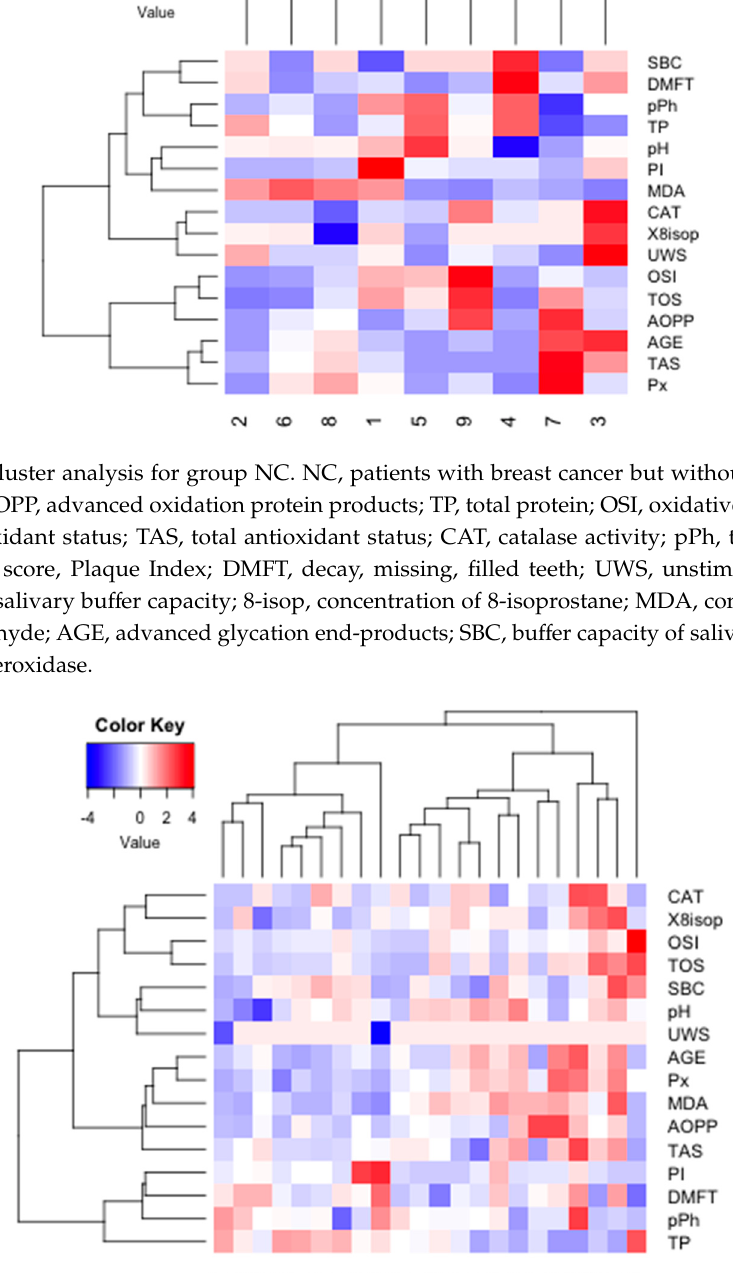
Figure 18. Cluster analysis for group PZ. PZ, generally healthy patients with the BRCA1 mutation; AOPP, advanced oxidation protein products; TP, total protein; OSI, oxidative stress index; TOS,